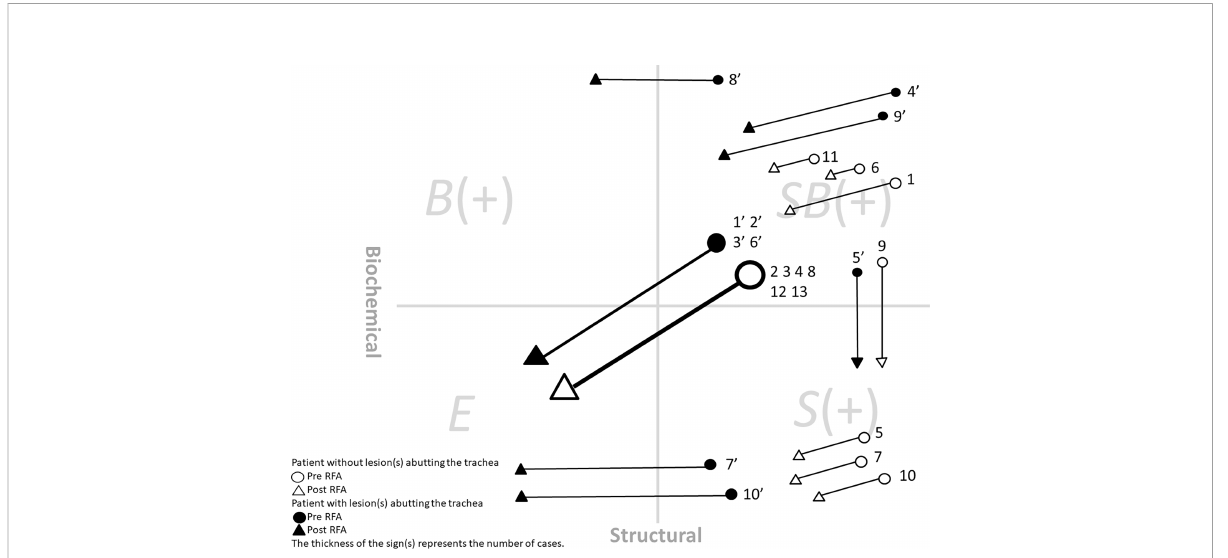
FIGURE 2 The treatment response and status change after RFA of all 23 patients. White symbols: Patients without lesion abutting the trachea. Black symbols: Patients with lesion abutting the trachea. The four quadrants in the fi gure indicated SB(+): structural and biochemical incomplete, B(+): biochemical incomplete, E, excellent, and S(+): structural incomplete.